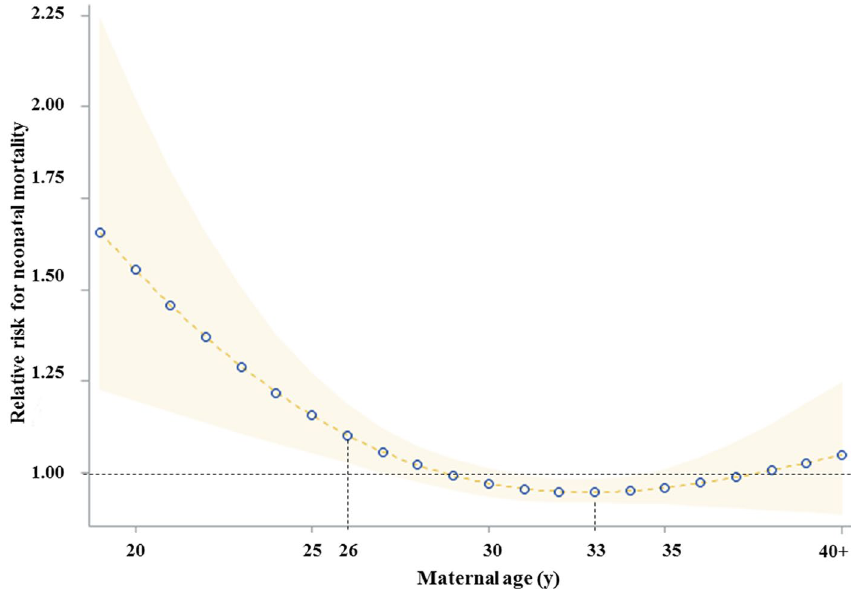
Figure 2. Association between maternal age and early neonatal